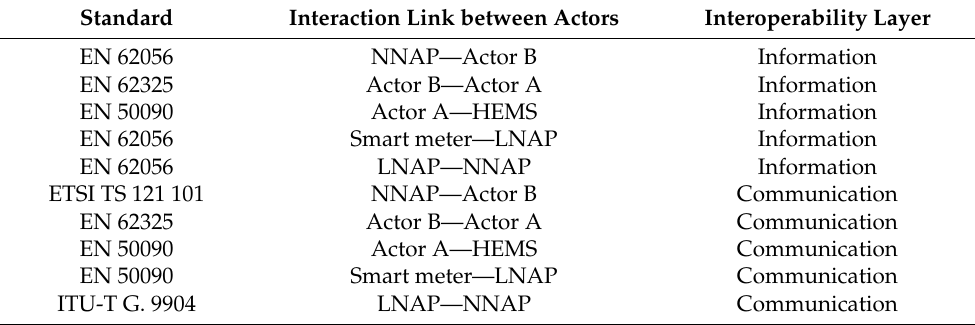
Table 1. BAPs for the equipment comprising the test bed.